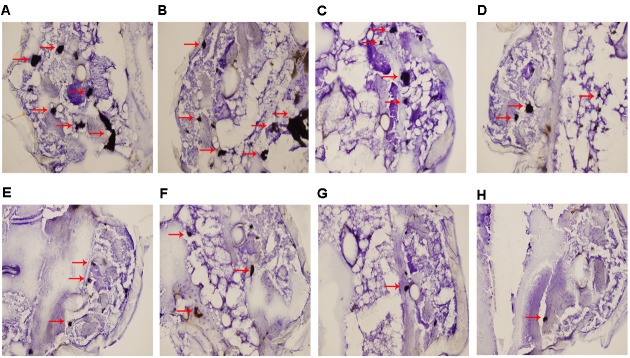
Histopathology study of infected G. mellonella treated with different drugs. After 72 h of infection, larvae infected with 5 × 106 cells/larva of resistant C. albicans (CA10) were processed for histopathology as described. (A,B) Untreated controls group; (C,D) larvae treated with fluconazole (160 μg/mL) group; (E,F) larvae treated with licofelone (80 μg/mL) group; (G,H) larvae treated with the combination of fluconazole (160 μg/mL) and licofelone (80 μg/mL) group. The experiment was repeated on 3 independent occasions.